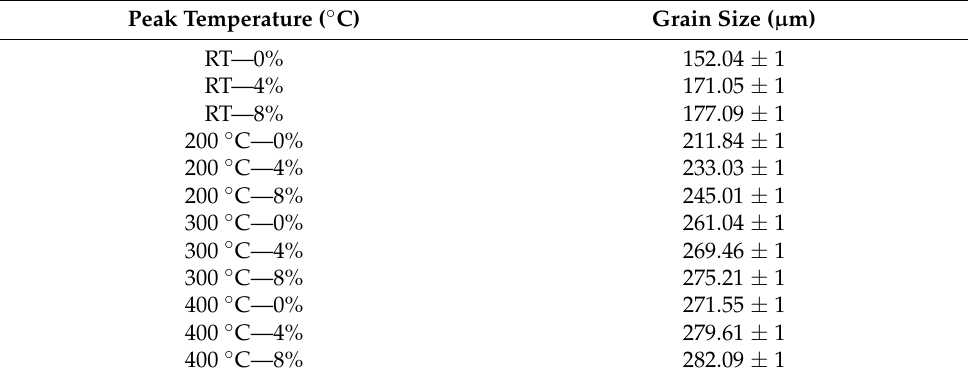
Table 2. Grain size under the thermal strain condition.